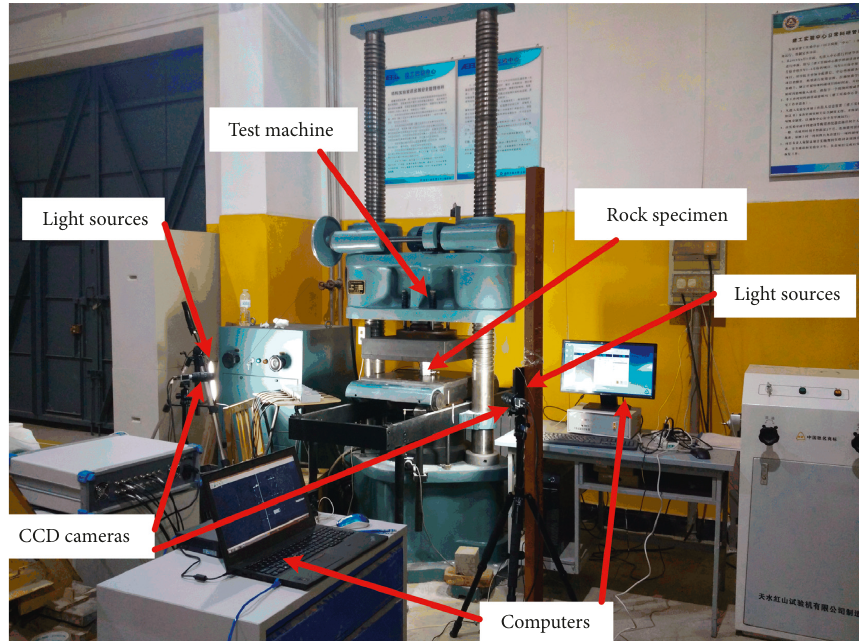
Figure 3: Physical diagram of test system.